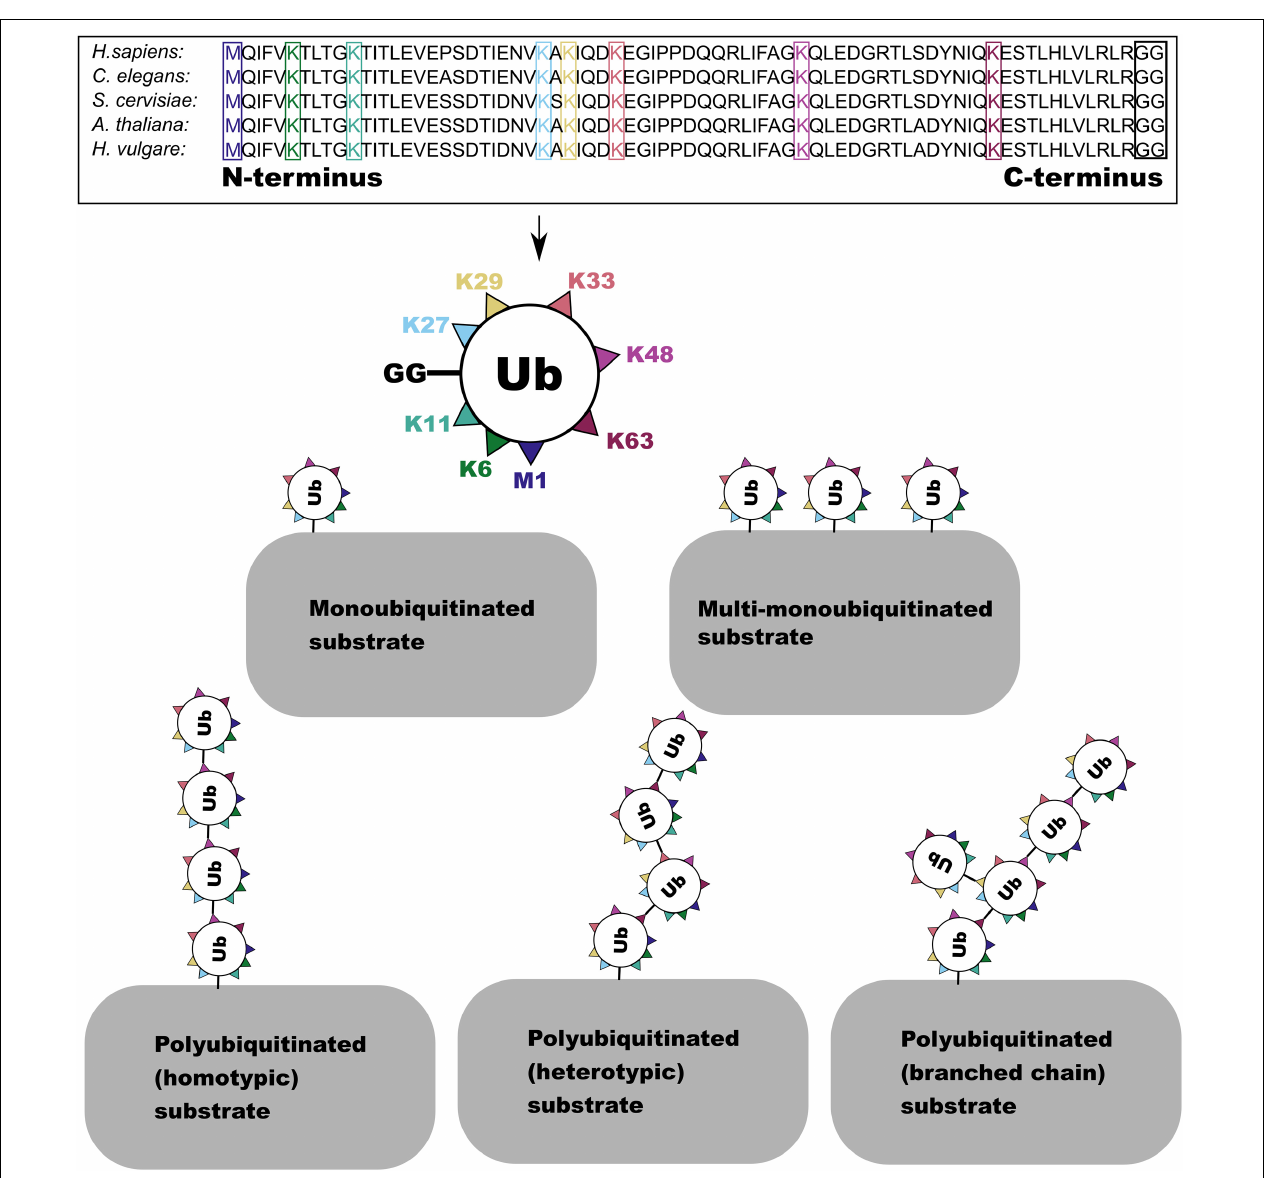
FIGURE 1 | The amino acid sequence of the ubiquitin monomer is highly conserved across eukaryotes. Here the one N terminal methionine (M) and seven lysine (K) residues in the sequence which are able to form linkages with the C-terminal GG residue (boxed in black) are highlighted. This enables the formation of several forms of ubiquitin and polyubiquitin